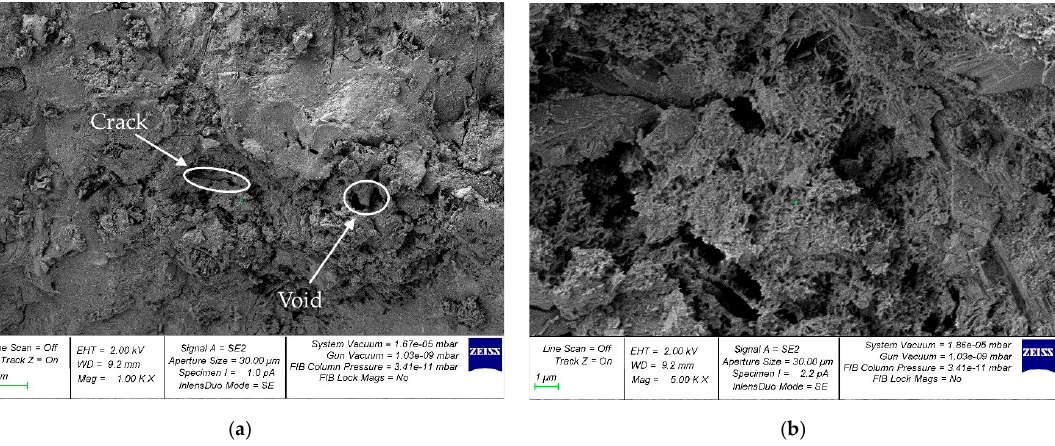
Figure 12. Micrographs of the structure of samples of hardened cement paste with partial replacement of mineral coarse aggregate with walnut shell, in the amount of 5%: ( a ) 1000× ( b ) 5000×.